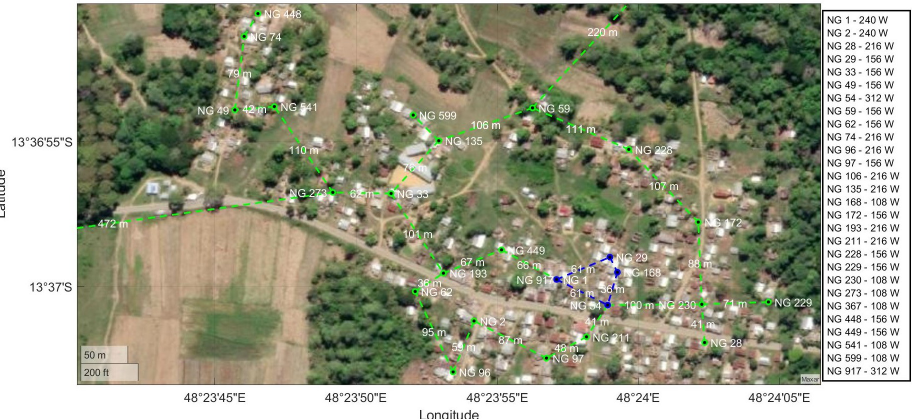
Figure 3. Geographical distribution of the nanogrids of Ambohimena ( black dots : nanogrids, blue lines : the microgrid installed in November 2021, green lines : extension project for